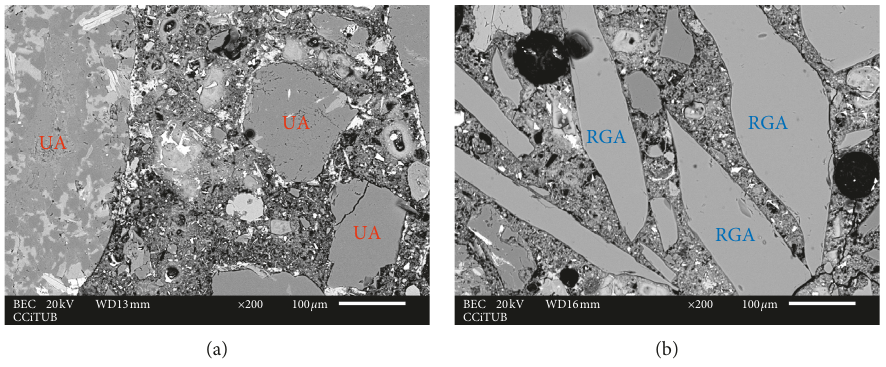
Figure 3: SEM images. (a) UM- B (UM with 100% UA). (b) 30RGM- B (RGM with 30%